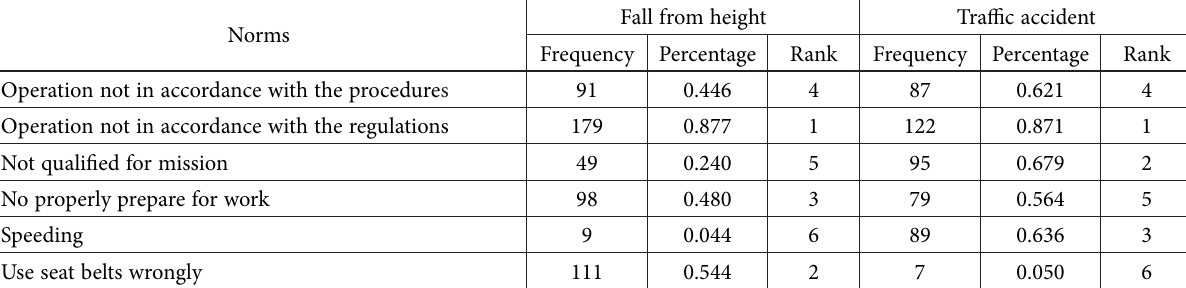
Table 9d. The norms of factor “violations” (main norms)